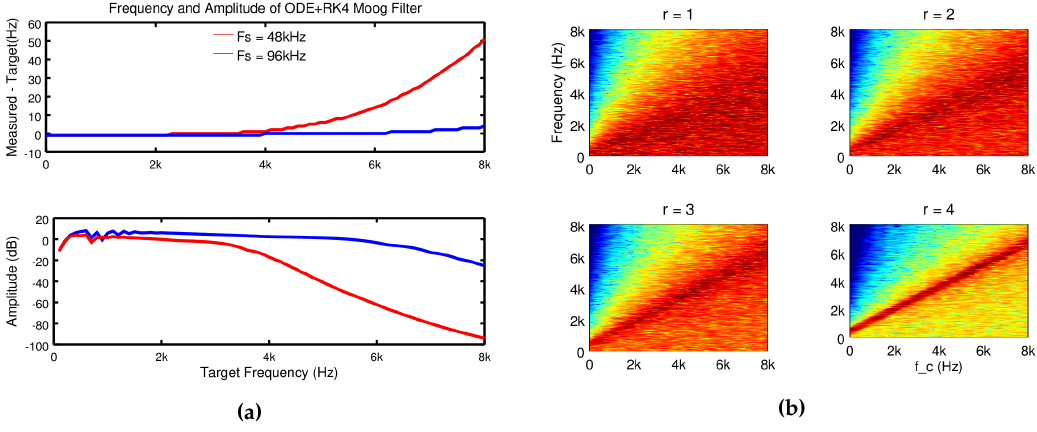
Figure 9. Plots illustrating the character of the ODE + RK4 implementation of the Moog filter. ( a ) Shown is the difference between target frequency and highest peak in the spectrum as well as amplitude for the ODE + RK4 Moog filter; ( b ) Sweeping f c across a noise stimulated Moog filter for various values of r (sampling rate is 48